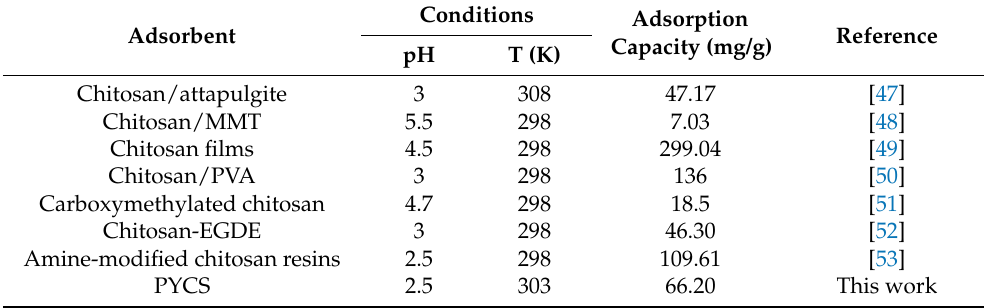
Table 3. Comparison of maximum adsorption capacities of Fe (III) on PYCS with other